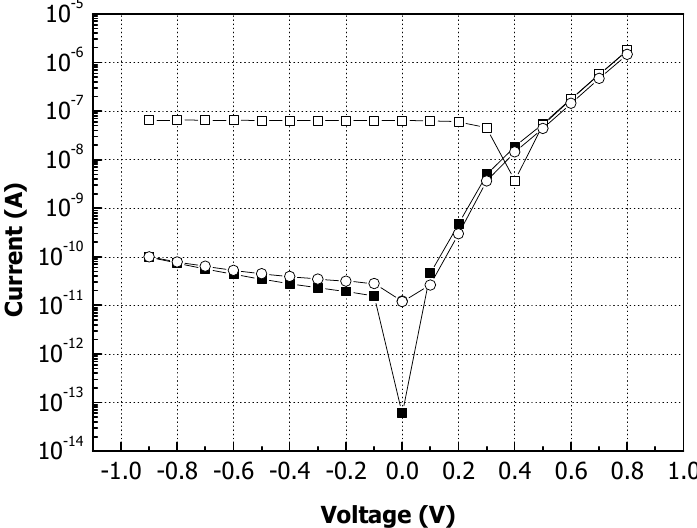
Figure 2. Current-voltage characteristics of the a-Si:H sensor in dark conditions (solid squares) and under monochromatic light at 465nm (open squares). Open circles refer to the device response utilized for the offset